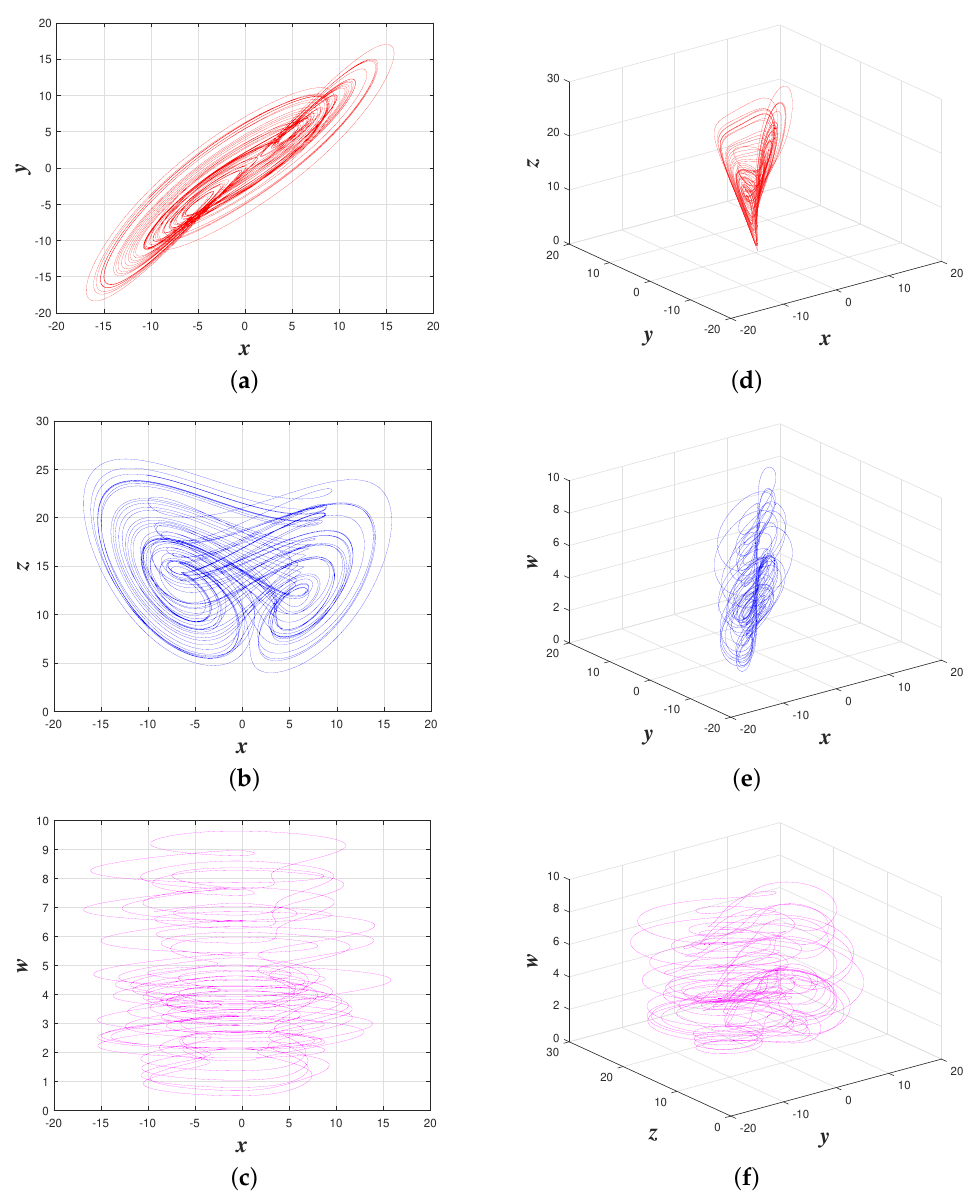
Figure 1. Six hyper-chaotic attractors of adopted hyper-chaotic Chen system: ( a ) x-y plane; ( b ) x-z plane; ( c ) x-w plane; ( d ) x-y-z plane; ( e ) x-y-w plane; ( f ) y-z-w